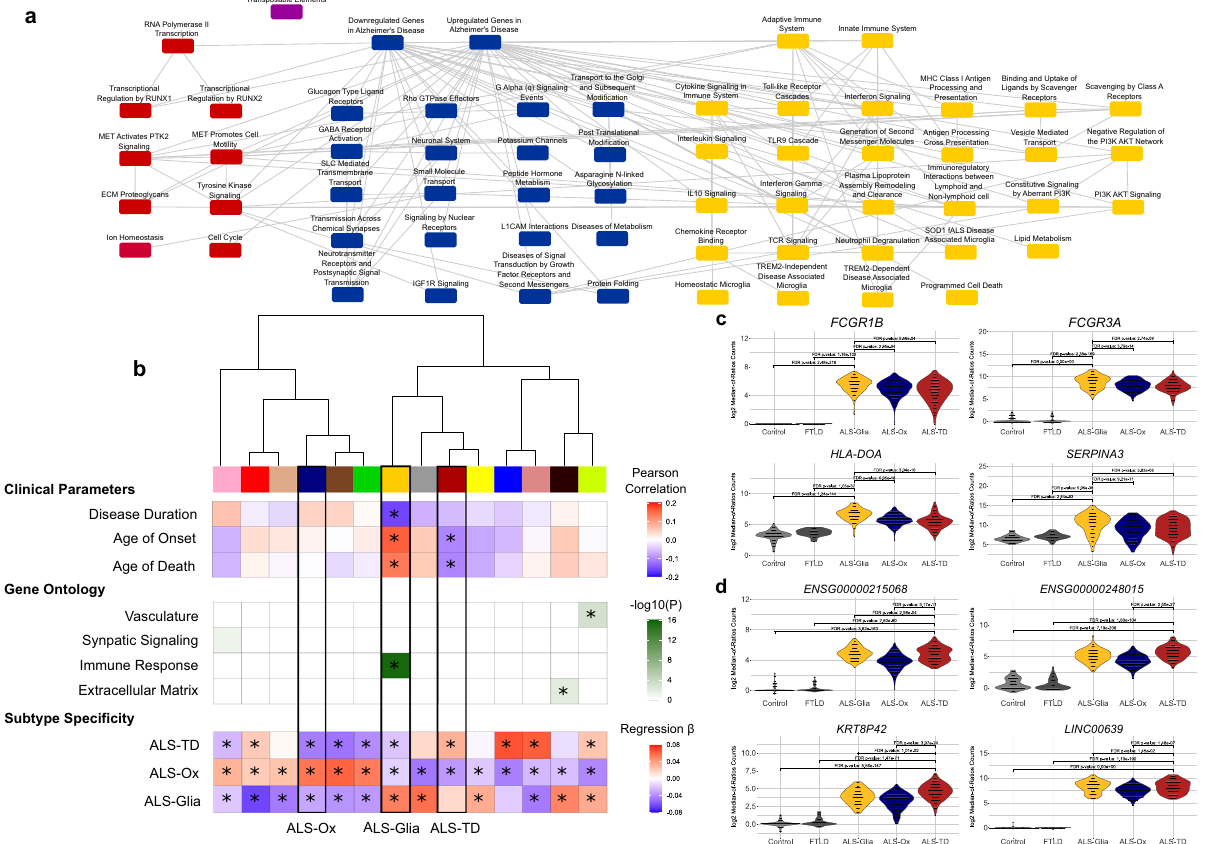
Fig.3|Networkconstructionelucidatessubtype-speci fi cdiseasepathwaysand eigengenes associated with ALS patient clinical outcomes. a Network of path- ways associated with the ALS cohort, color coded by subtype, with maroon indi- cating ALS-TD, navy denoting ALS-Ox, and gold signifying ALS-Glia. b WGCNA identi fi es gene subsets signi fi cantly correlated with ALS patient age of disease onset, age of death, and disease duration (univariate regression, two-tailed). Eigengene labels, moving left to right in the dendrogram, are: pink, red, tan, navy (ALS-Ox), brown, green, gold (ALS-Glia), gray, maroon (ALS-TD), yellow, blue, sal- mon, black, and green-yellow. Eigengenes were enriched for gene ontology and Bonferroni-adjusted p -values are shown (Fisher ’ s exact test, one-sided). Subtype- speci fi c expression of eigengenes was determined using dummy regression (two-